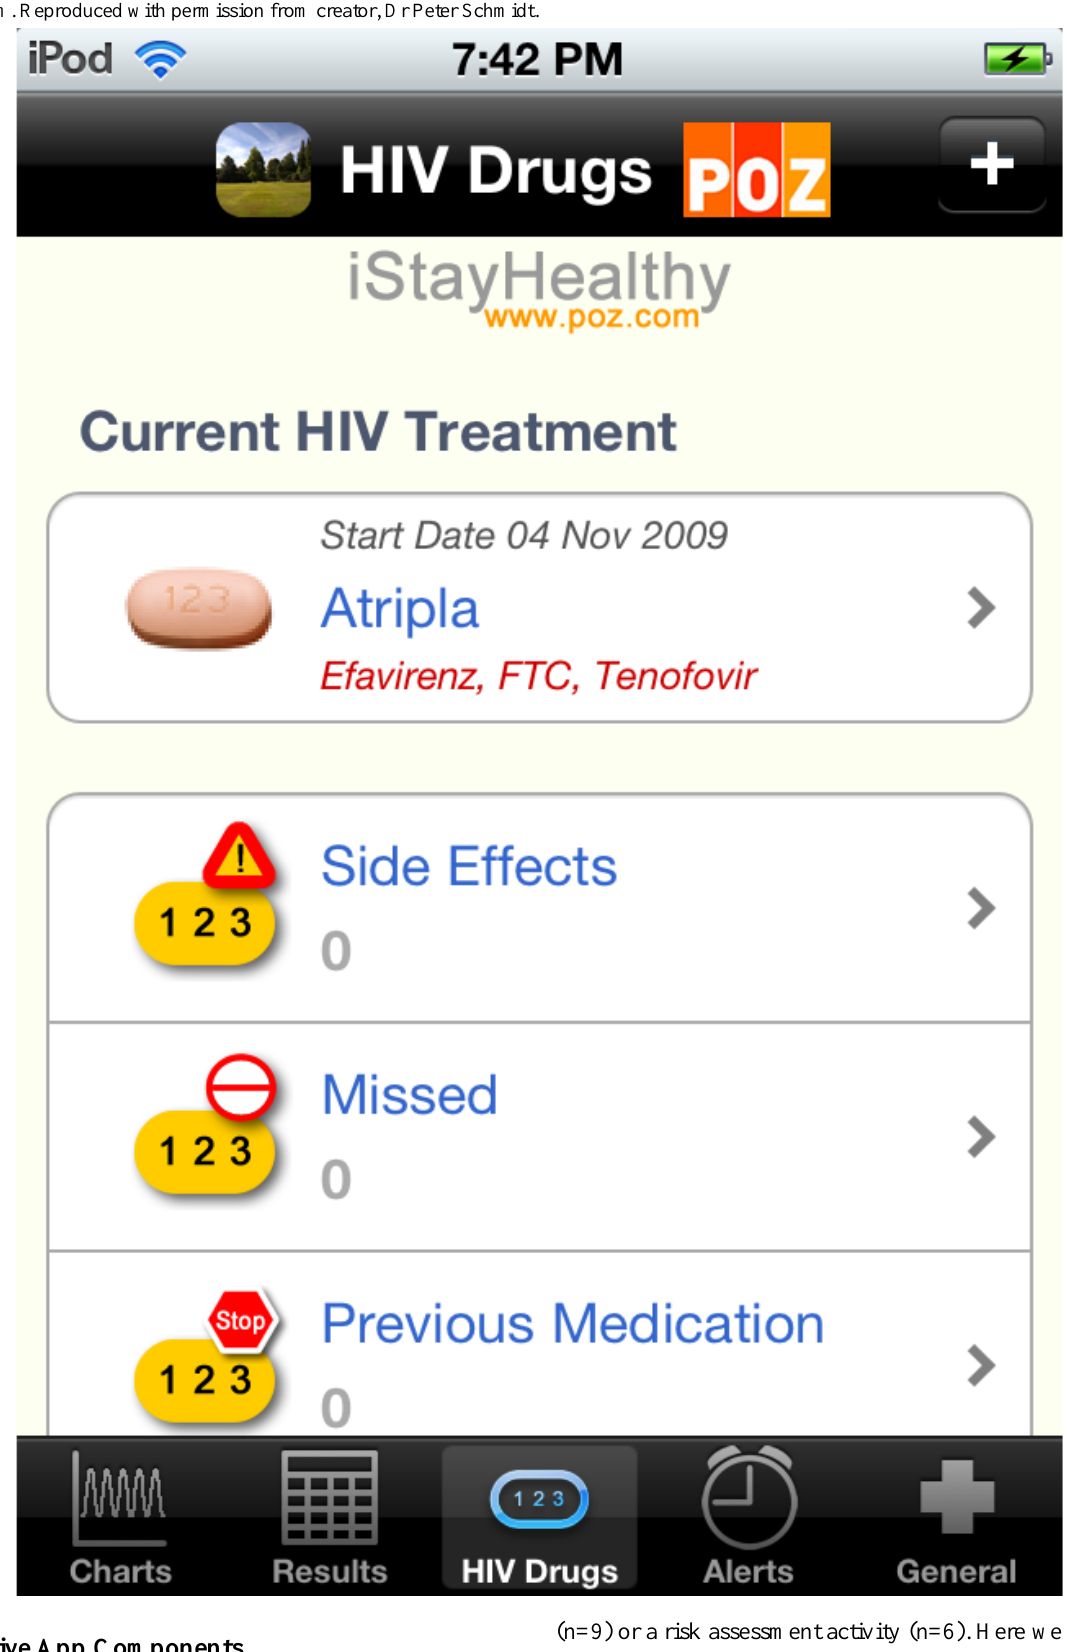
Figure 3. Screenshot of iStayHealthy app’s user-generated HIV medication list. iPhone version shown on Apple iPhone 4. Actual phone screen